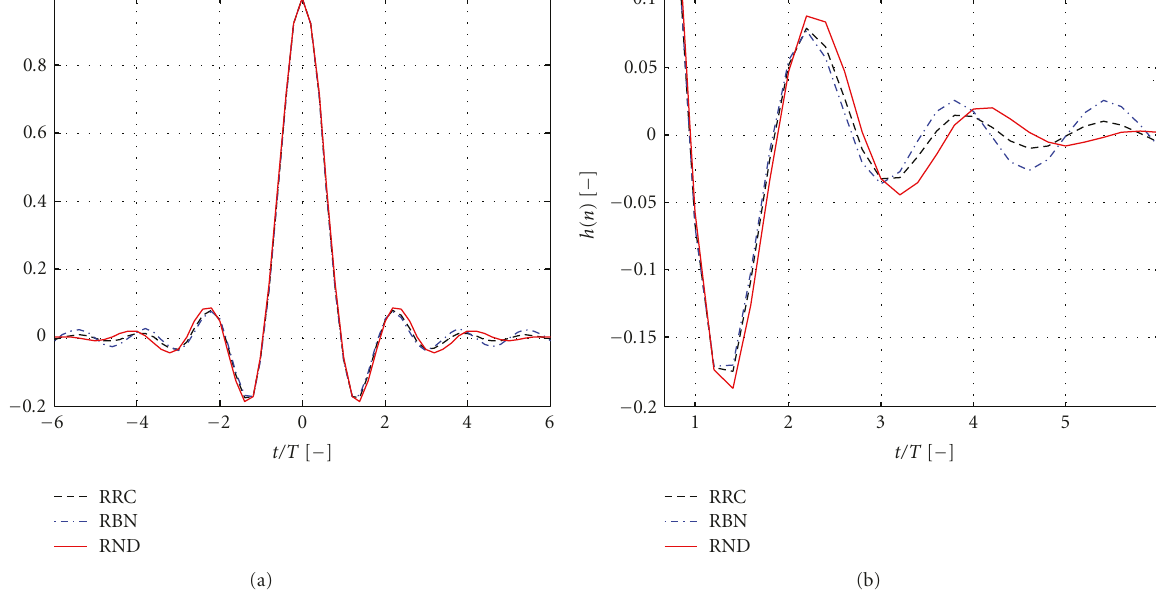
Figure 8: Normalized impulse responses of the truncated square root RC filter (RRC); square root B -filter (RBN); square root Nyquist δ -filter (RND). α = 0 . 284; G D = 6; N = 5; N O =